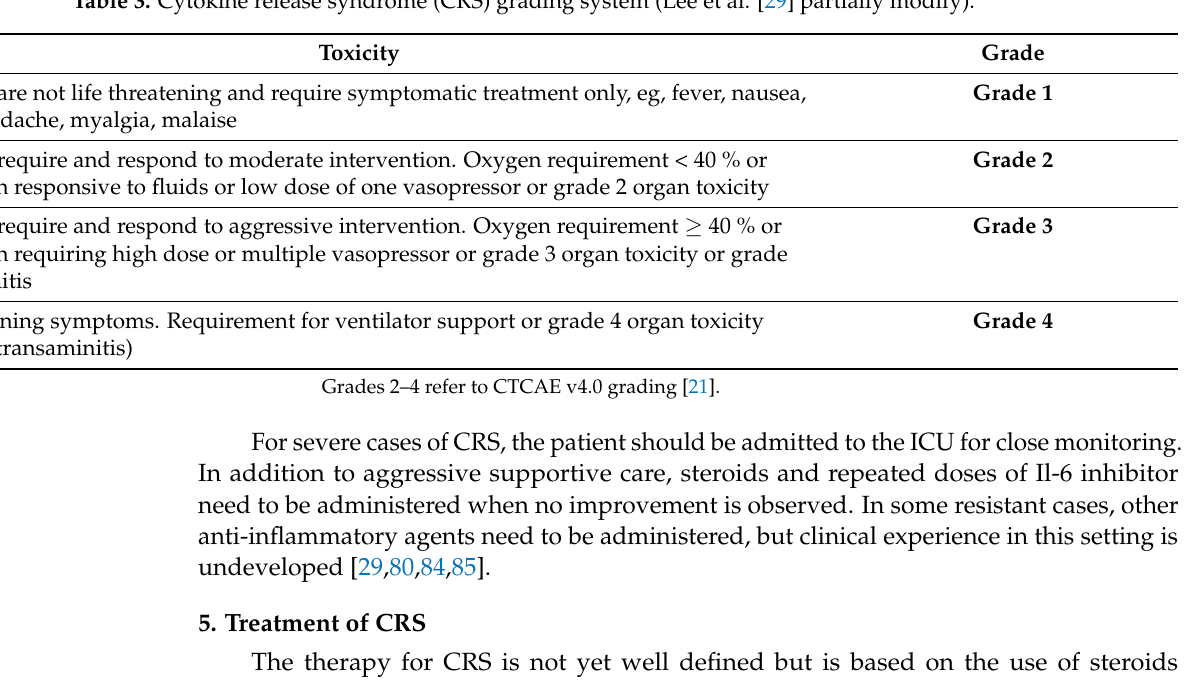
Table 3. Cytokine release syndrome (CRS) grading system (Lee et al. [29] partially